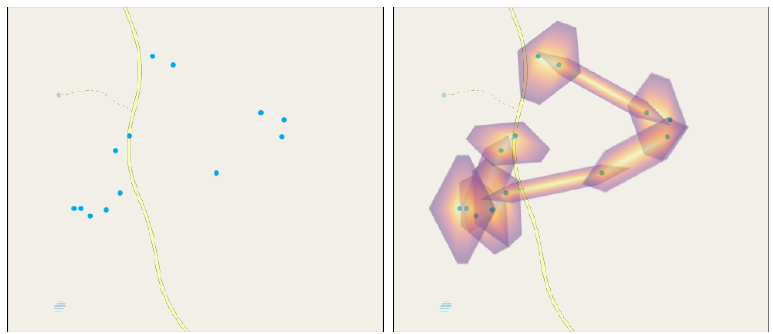
Figure 13. The above figure illustrates the application of “visit probability” in the study of animal movement. The figure to the left indicates the movement of a GPS tagged African Buffalo in a day. The figure to the right shows the visit probabilistic model applied to compensate for the missing data